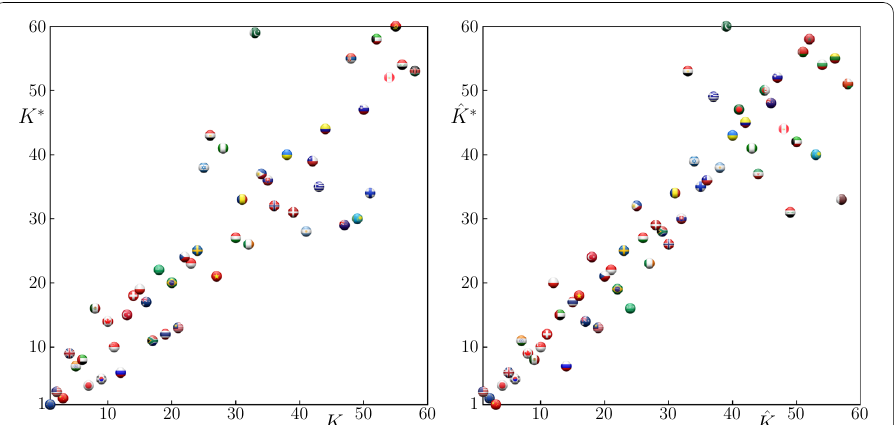
Fig. 1 PageRank-CheiRank plane of countries in 2018. Circles with country flags show positions of countries on the plane of PageRank-CheiRank indexes ( K , K ∗ ) (summation is done over all products) (left panel) and on the plane of ImportRank-ExportRank ˆ K , ˆ K ∗ from trade volume (right panel); data are shown only for index values less than 61 for year 2018; data for years 2012, 2014, 2016 are shown in Additional file 1: Fig. A1; KEU9 is marked by EU